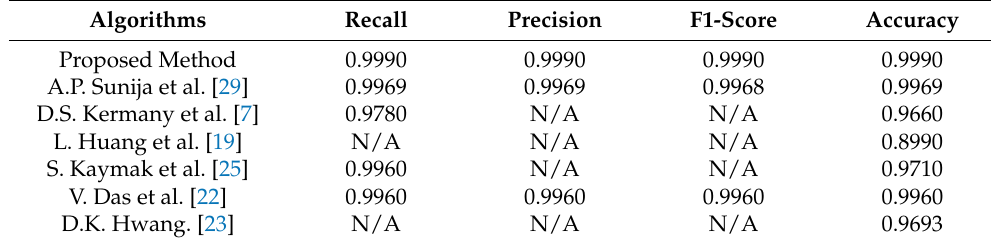
Table 11. Comparison of methods.